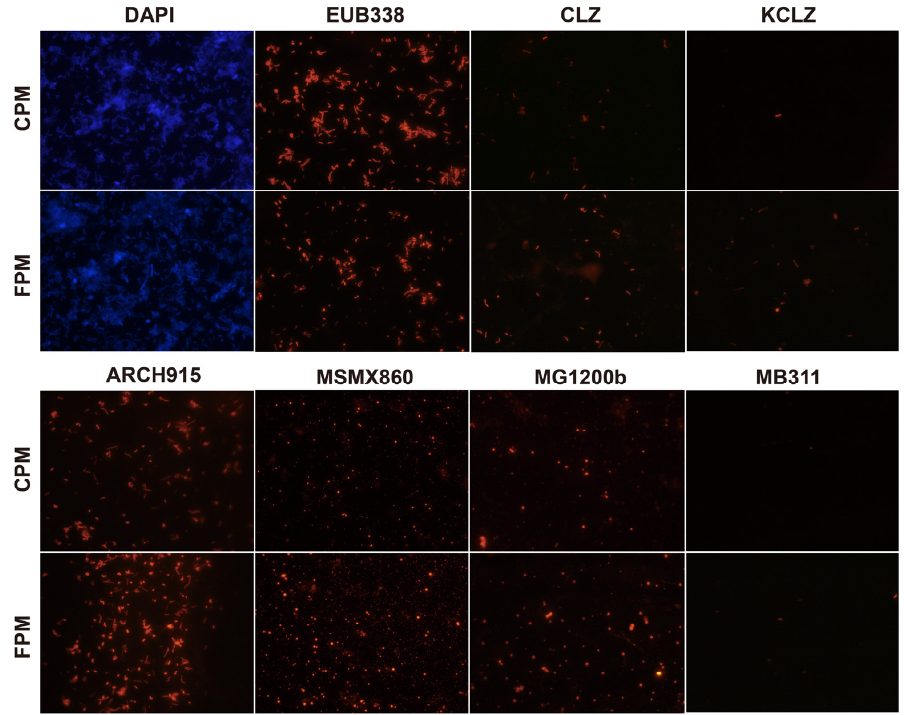
Figure 1. Differences in core microbes of fortified artificial pit mud (FPM) and conventional artificial pit mud (CPM) based on fluorescence in situ hybridization. DAPI, total microbes; EUB338, eubacteria; CLZ, Clostridium ; KCLZ, Clostridium kluyveri ; ARCH915, archaea; MSMX860, Methanosarcinales ; MG1200b, Methanomicrobiales ; MB311, Methanobacteriales .